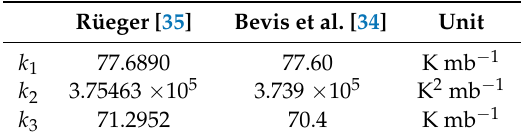
Table 2. Values of the refractivity coefficients available in GSI v3.3.